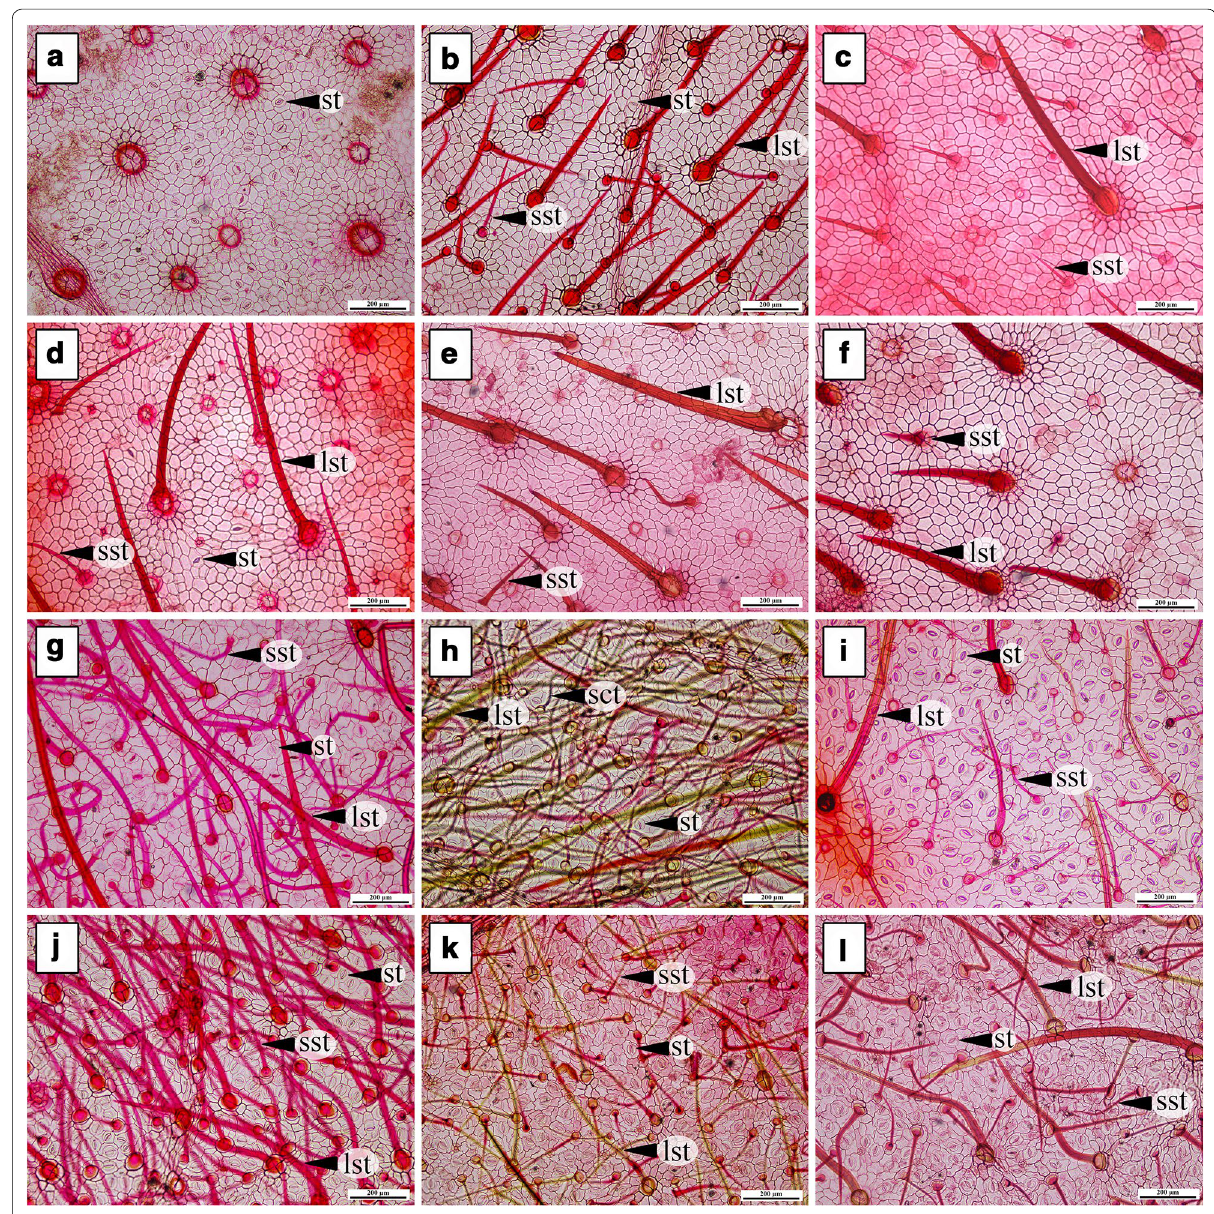
Fig. 3 Trichomes on adaxial ( a – f ) and abaxial leaf surfaces ( g – l ) under light microscopy (LM). a , g A. breviscapa , b , h A. kerrii , c , i A. suddeeana , d , j A. variabilis , e , k Argyreia 1 and f , l Argyreia 2 ( lst large straight trichome, sst small straight trichome, sct small curly trichome, st stomata). Scale bar 200